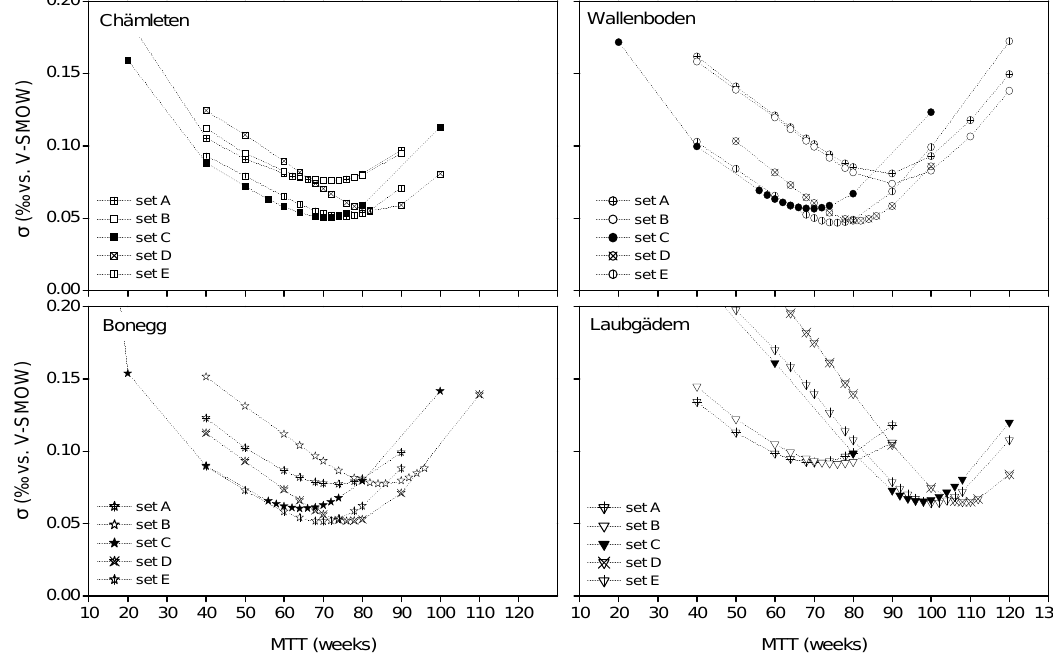
Figure 7: Uncertainty analysis of MTT calculation for the micro catchments with different input parameter sets.